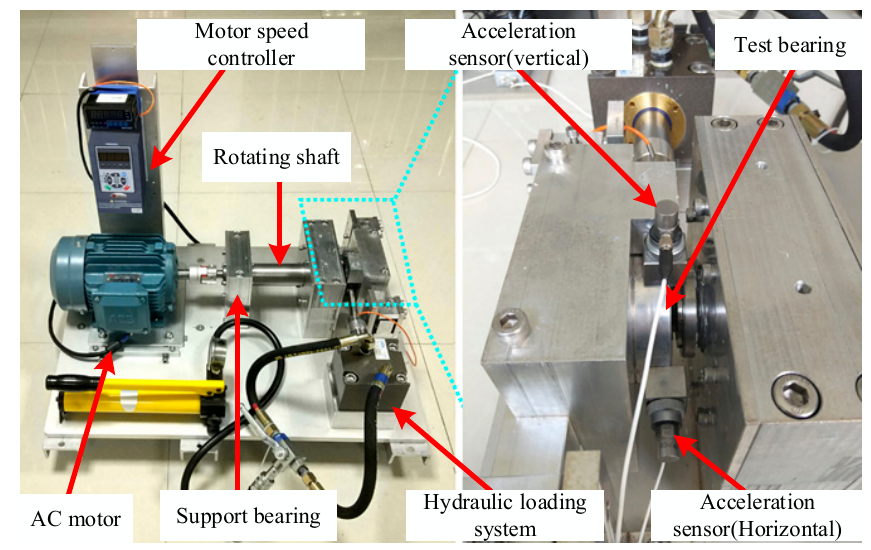
Figure 12. The experimental platform of XJTU. Table 4. LDK UER 204 rolling bearing parameters.